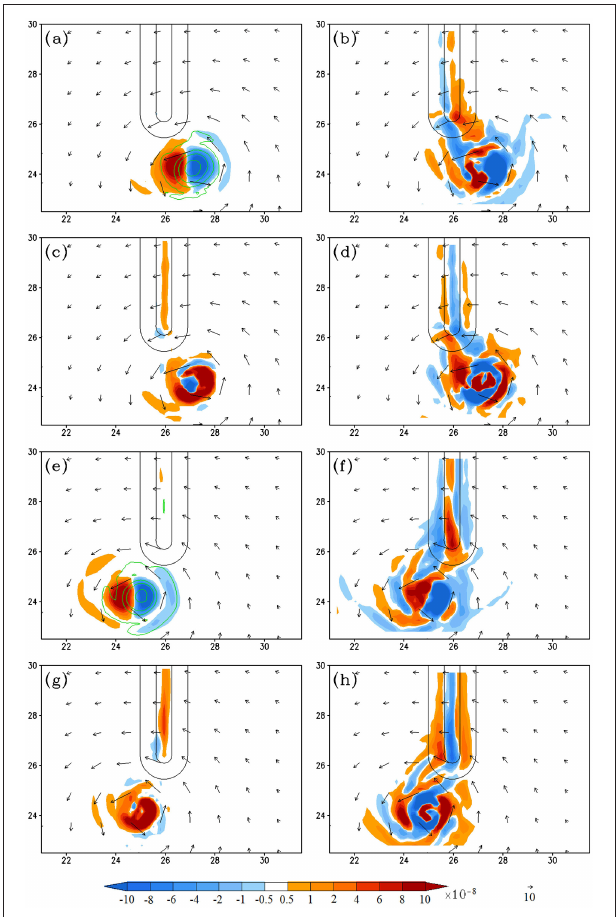
FIGURE 11 | (Track A3) The vorticity budget analysis for Track A3: (A–D) are the 950–500hPa layer-averaged vorticity tendency (VT), horizontal vorticity advection, relative vorticity stretching, and residual term, respectively, at 171h. (E–H) Are the same as (A–D) , respectively, but at 186h. The units of the coordinates in the x and y directions are 100km. The vertical vorticity fields are depicted by contours (0.0001, 0.0005, 0.001, 0.002, 0.003 s − 1 ) in (A,E)